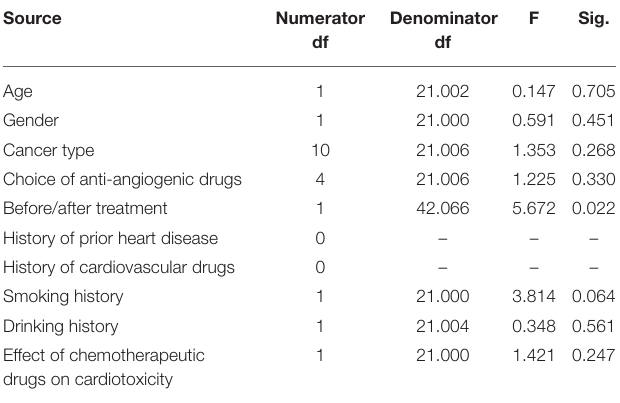
TABLE 4 | Type III test of fixed effects of LDH.